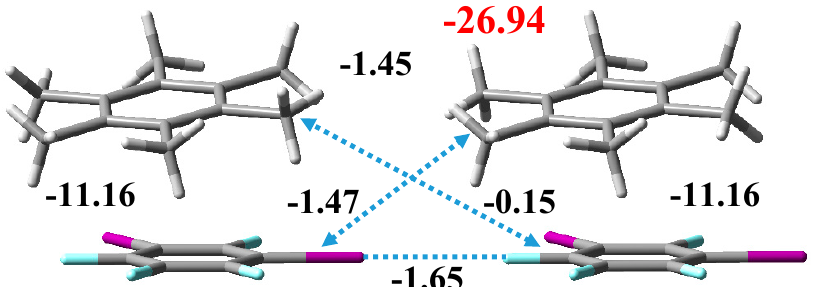
Figure 7. The loop formed by two HMB molecules and two 1,3-DITFB molecules. The black numbers (in kcal / mol) are the interaction energies of two neighboring molecules, and the red number (in kcal / mol) is the total interaction energy of the four molecules.